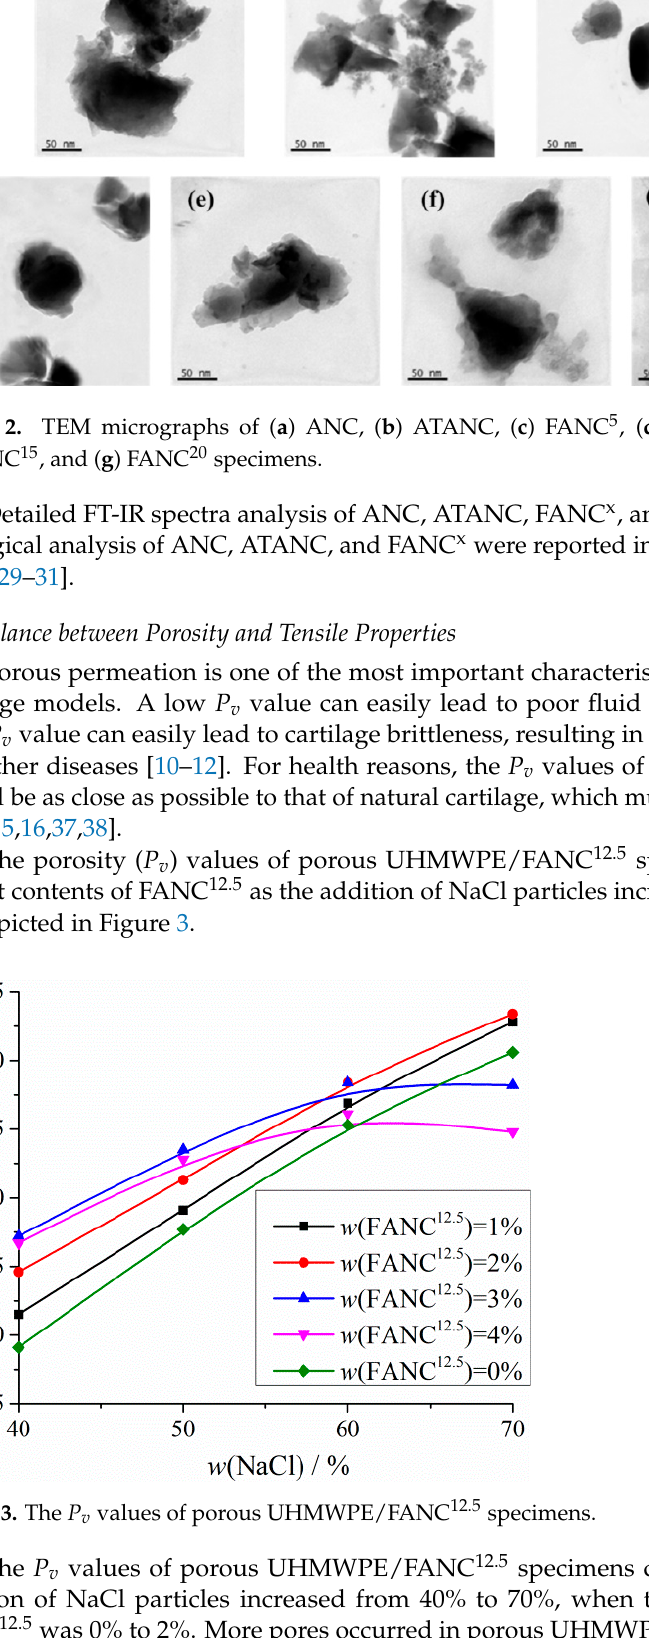
Figure 3. The P v values of porous UHMWPE/FANC 12.5 specimens. The P v values of porous UHMWPE/FANC 12.5 specimens clearly increased as the addition of NaCl particles increased from 40% to 70%, when the mass percentage of FANC 12.5 was 0% to 2%. More pores occurred in porous UHMWPE/FANC 12.5